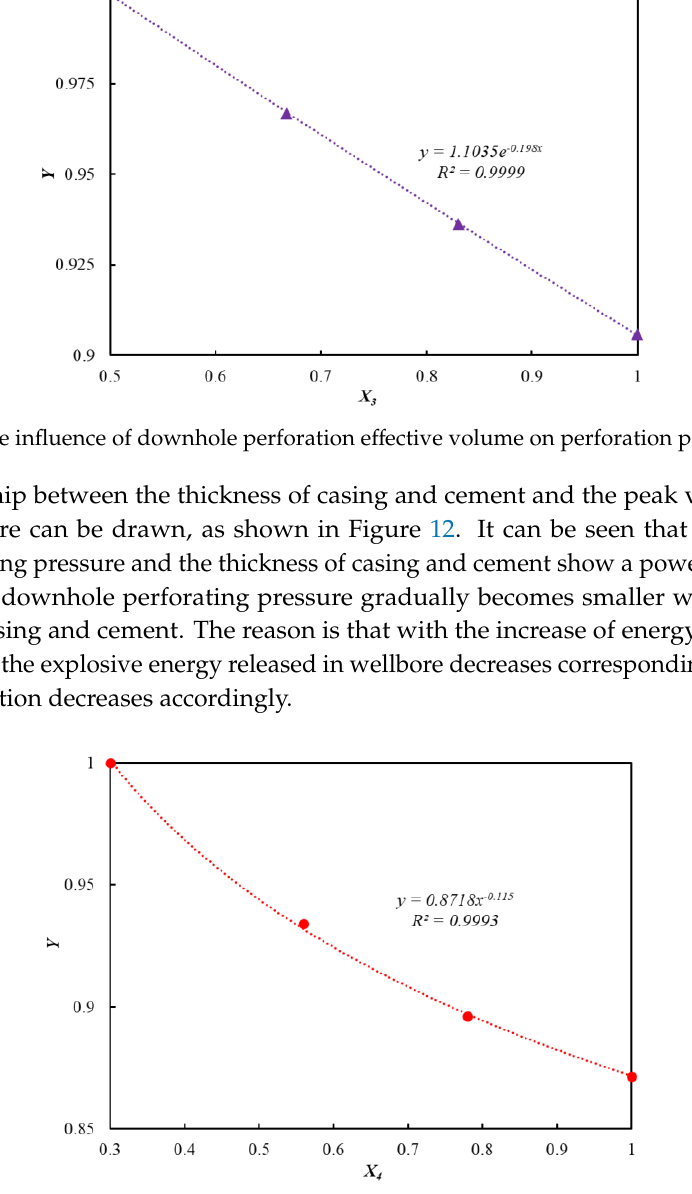
Figure 13. The influence of formation elastic modulus on downhole perforation peak pressure. Based on the above analysis, the influence laws of the factors on the downhole perforation peak pressure have been obtained. In order to obtain a prediction model that can be used to calculate the peak pressure of perforation pulsation accurately in engineering, it can be fitted based on a large number of numerical simulation data by considering multi-factor changes. Equation (12) can be written further as: